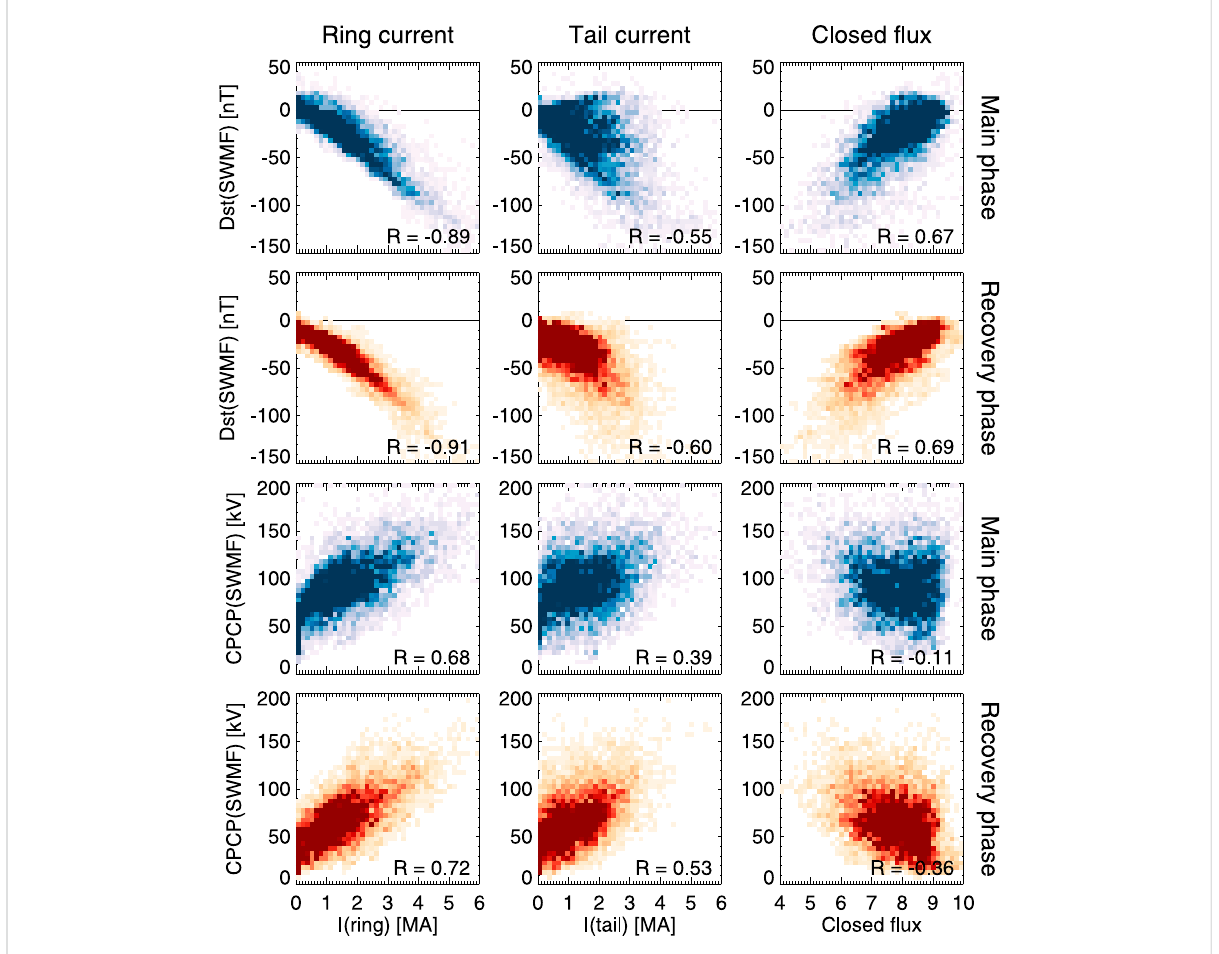
FIGURE 8 (Toptworows)Dstand(Bottomtworows)CPCPfromtheSWMFsimulationasfunctionof(Leftcolumn)totalringcurrent;(Middlecolumn)total tail current; and (Right column) Closed magnetic fl ux in the tail (see de fi nitions given in the text). The storm main phase (blue) and recovery phase (orange) are shown separately. The data are snapshotstaken at 15-min cadence in the magnetotail, tagged with the 30-min smoothed values ofthe indices. The heat maps indicate the share of points falling in each